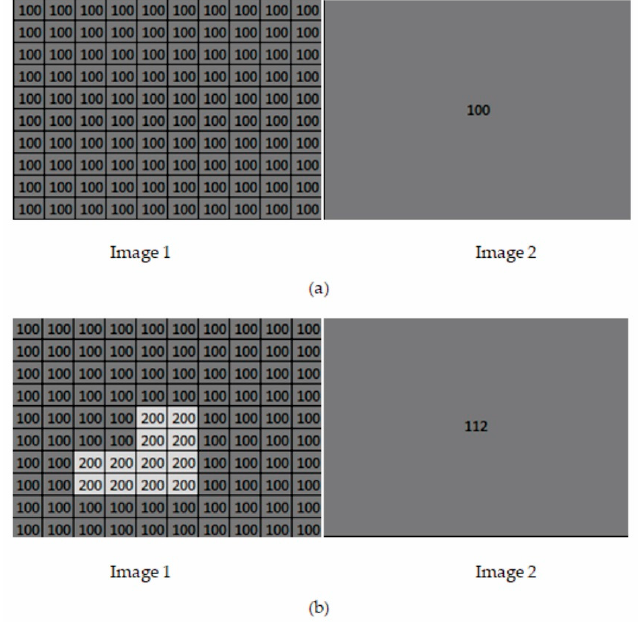
Figure 6. Sample images showing the idea of detail detection. Image 1 is an example of a high-resolution panchromatic image, Image 2 is an example of the intensity of a low-resolution, multispectral image. Two cases are shown: ( a ) there are no spatial details in the high-resolution image, ( b ) there are spatial details in the high-resolution image.